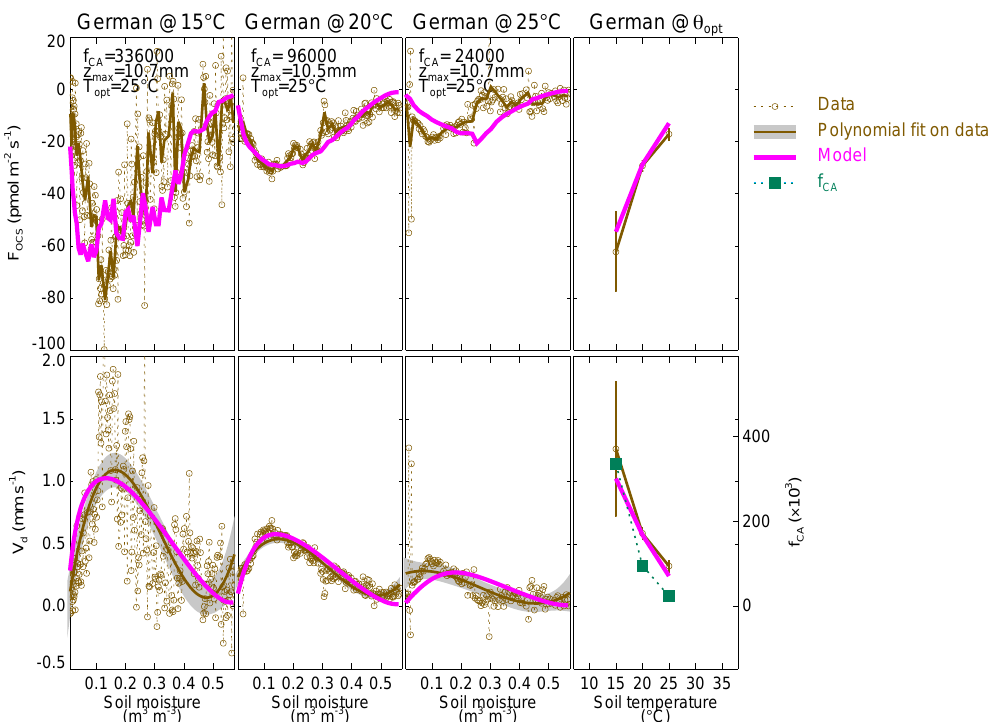
Figure 9. Observed and modelled soil–air OCS flux ( F OCS ) and deposition velocity ( V d ) during soil drying at different incubation temper- atures (indicated above each panel) and their value at a soil moisture content W opt = 0.12m 3 m − 3 (far right panels). The soil moisture and temperature response curves shown here were recalculated from data by Van Diest and Kesselmeier (2008) (open circles and brown line) or computed with our model (thick pink line) using the diffusivity model of Moldrup et al. (2003). For each incubation temperature, a different set of model parameters ( f CA , z max , T opt ) was used as indicated in each panel. The data shown here are representative of an agricultural soil near Mainz in Germany (soil weight is 200g).